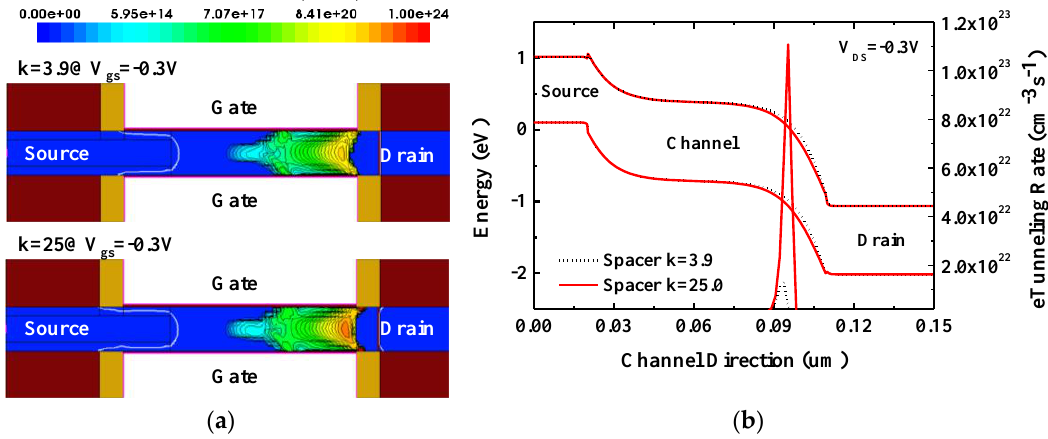
Figure 5. ( a ) 2D contour mapping of electron tunneling rate at V GS = − 0.3 V and V DS = 1.0 V for the spacers with κ = 3.9 and κ = 25. ( b ) One-dimensional (1D) energy band diagram along the channel direction and electron tunneling rate between the channel and drain.